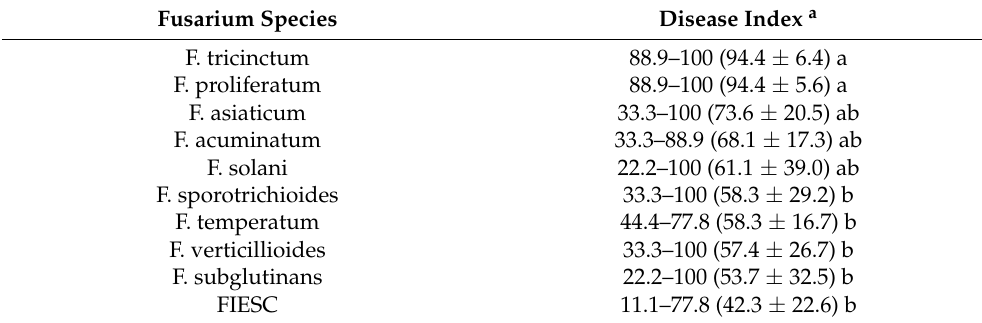
Table 2. Disease index and severity degree of maize leaves inoculated with 10 Fusarium